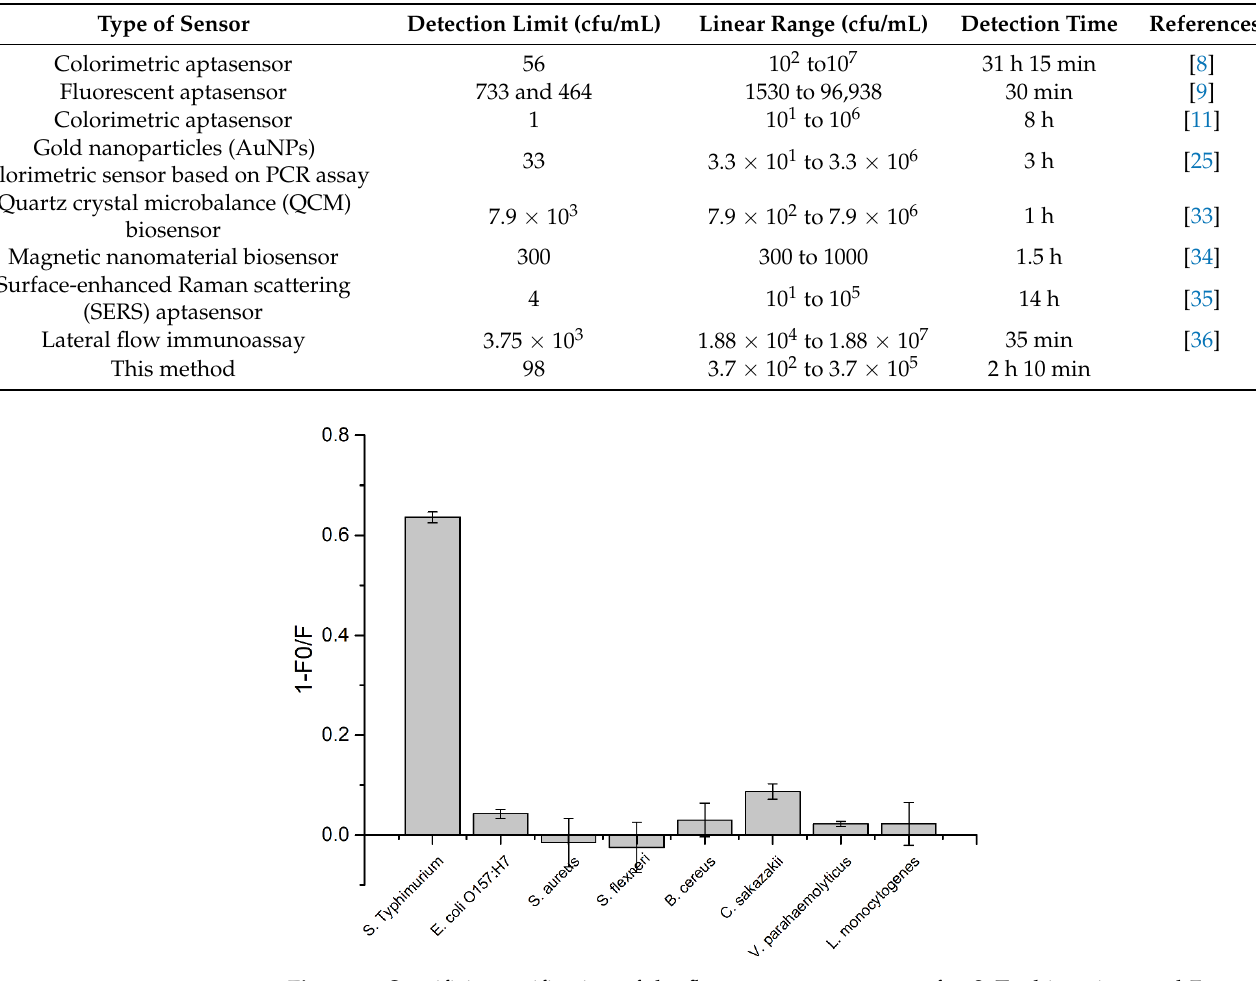
Figure 6. Specificity verification of the fluorescence aptasensor for S. Typhimurium and 7 non- S. Typhimurium bacteria. Error bars denote the standard deviation of 3 repetitive experiments. The concentration of S. Typhimurium was selected as 10 5 cfu/mL.